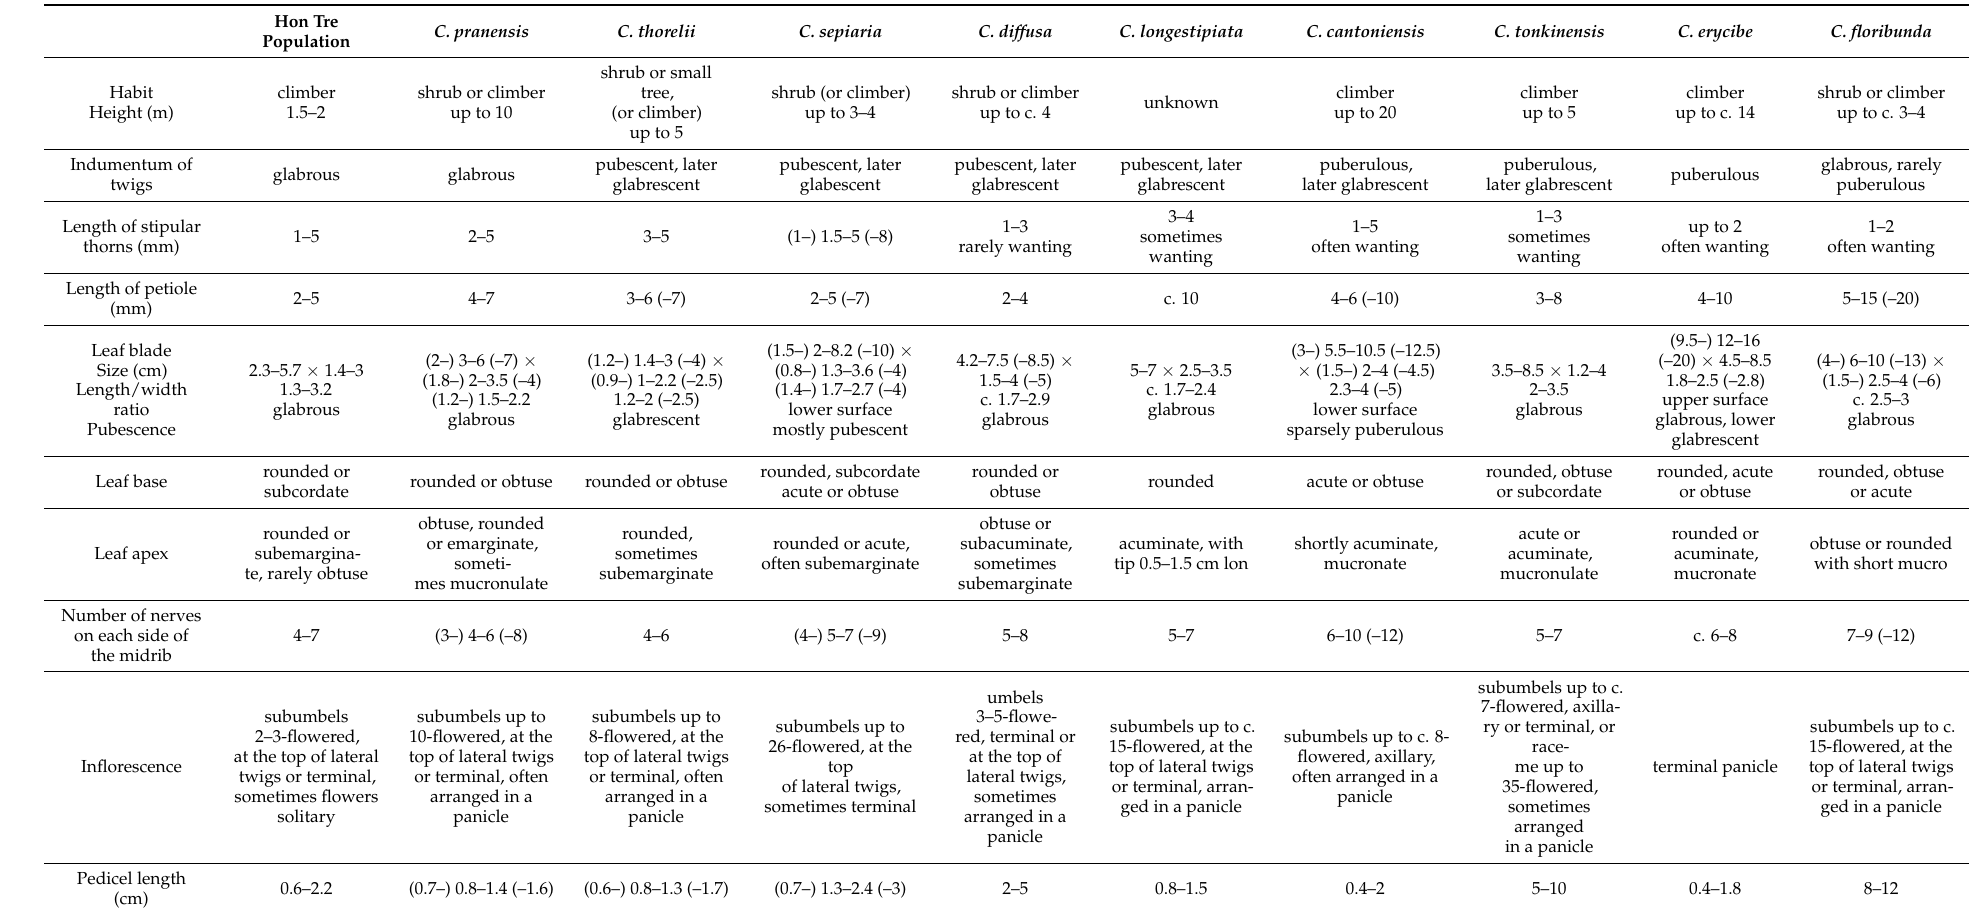
Table 1. Features of the Hon Tre Capparis population compared with those of related